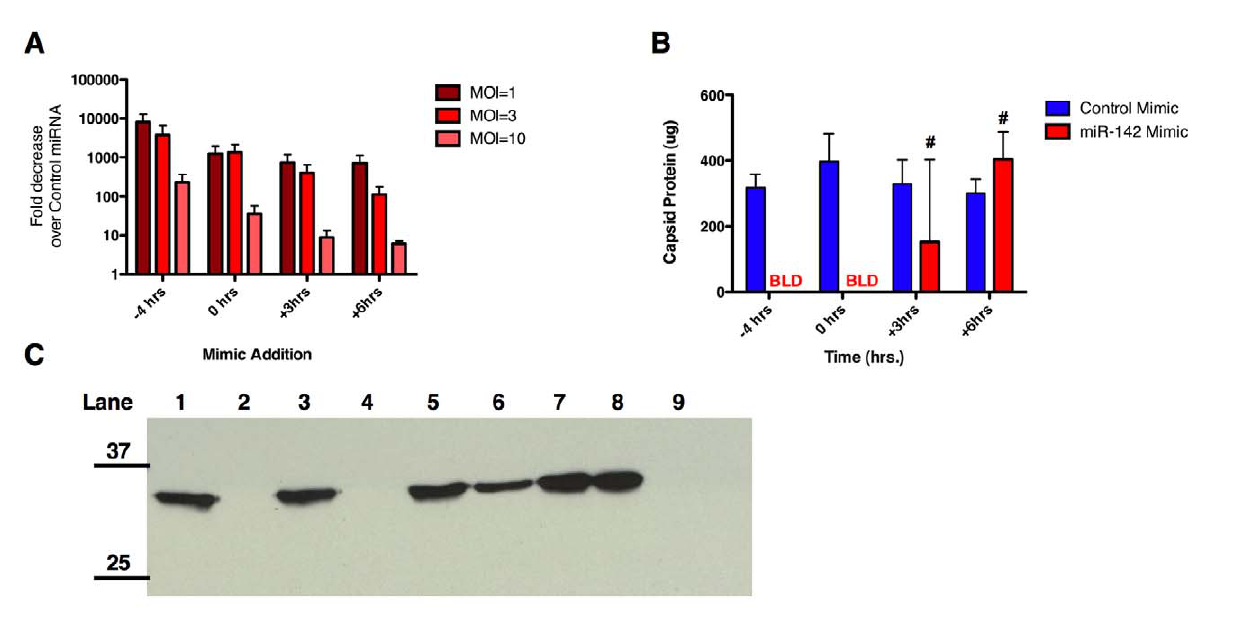
Figure 4. MicroRNAs can affect particle to infectivity ratio of CVA21. (A) Fold change in CVA21 142T RNA as determined by qRT-PCR of viral RNA from supernatant of infected cells at indicated time pre/post miRNA mimic addition. Fold decrease expressed as ratio of CVA 142T RNA in the presence of miR-142 mimic/CVA 142T RNA in the presence of control miRNA mimic (at indicated MOI). (B) Protein assay of sucrose-purified virus collected in the presence of miRNA mimics added at 4 hours prior, or 0, 3, or 6 hours after virus infection at MOI=1. (C) Western blot with anti-CVA21 of sucrose-purified supernatant run on 12.5% SDS-PAGE gel from miRNA mimic timecourse at MOI=1. Lane 1-Control mimic -4 hrs pi + CVA 142T; Lane 2- 142 mimic -4 hrs pi + CVA 142T; Lane 3- Control mimic 0 hrs pi + CVA 142T; Lane 4- 142 mimic 0 hrs pi + CVA 142T; Lane 5- Control mimic + 3 hrs pi + CVA 142T; Lane 6- 142 mimic + 3 hrs pi + CVA 142T; Lane 7- Control mimic + 6 hrs pi + CVA 142T; Lane 8- 142 mimic + 6 hrs pi + CVA 142T; Lane 9- Mock infected. BLD- below limit of detection. # p=ns (vs. H1-HeLa + Control mimic). pi: post